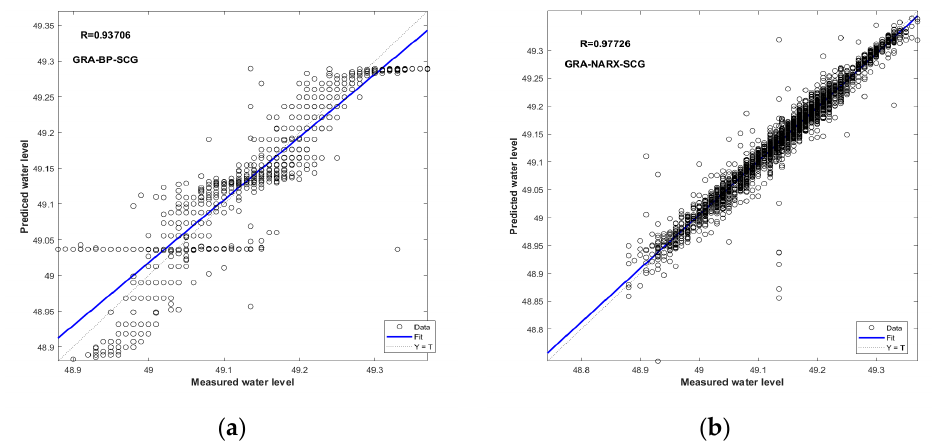
Figure 11. Scatter plots of measured and predicted water levels for the GRA-NARX and GRA-BP models using SCG as the training algorithm: ( a ) GRA-BP-SCG, ( b ) GRA-NARX-SCG.